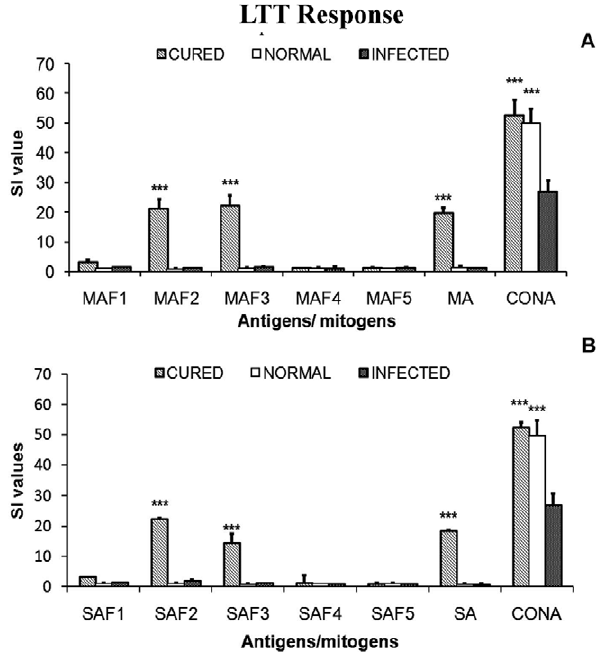
Figure 7. Lymphoproliferative response of mononuclear cells of lymph nodes from normal, L.donovani infected as well as cured (with Miltefosine at 40 mg/kgx5 days) hamsters in response against MA (A) and SA (B).